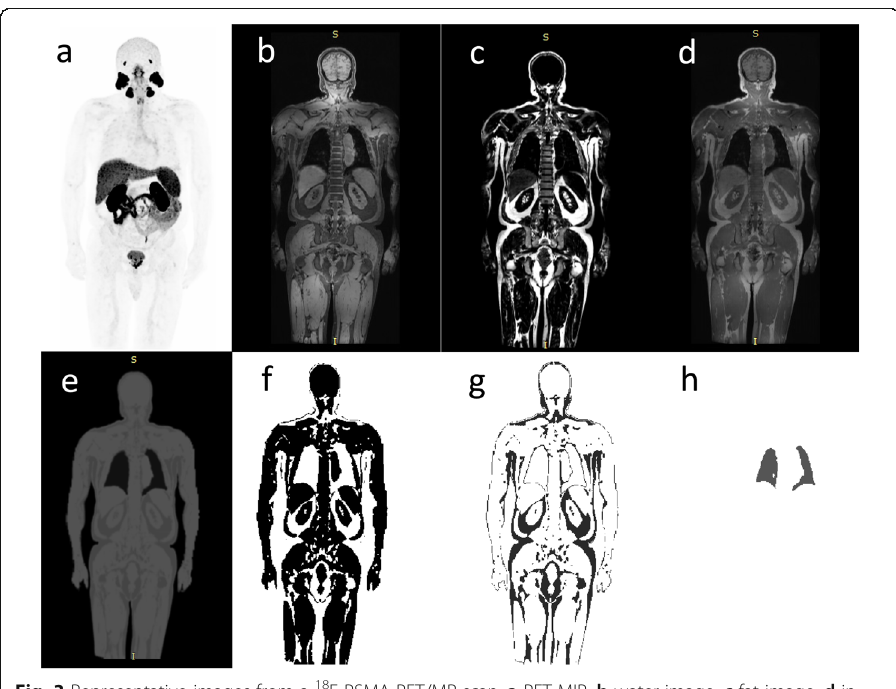
Fig. 3 Representative images from a 18 F-PSMA PET/MR scan. a PET MIP, b water image, c fat image, d in- phase image, e MRAC map, f water segmented from MRAC, g fat segmented from MRAC, and h lung segmented from